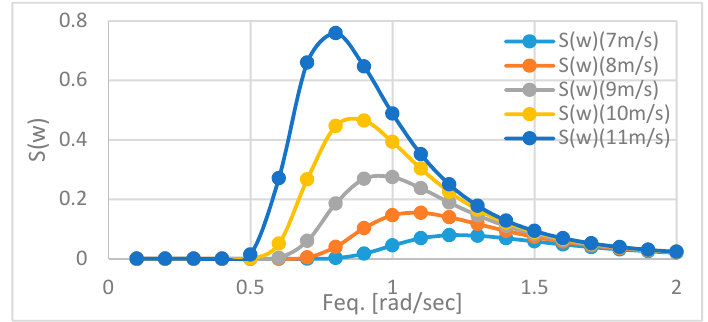
Figure 4. Wave spectrum of the selected location based on the wind speed.